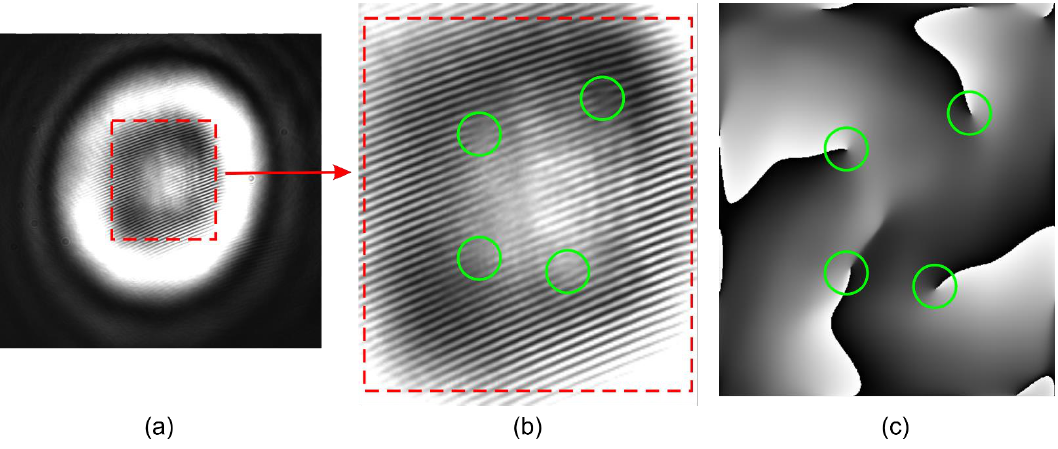
Figure 9. Experimental results with a separated optical vortex with the topological charge of m = 4. The intensity was recorded with an additional beam (Figure 7): ( a ) intensity, ( b ) magnified intensity area, ( c ) phase profile. The green circles represent the locations of the vortex points.